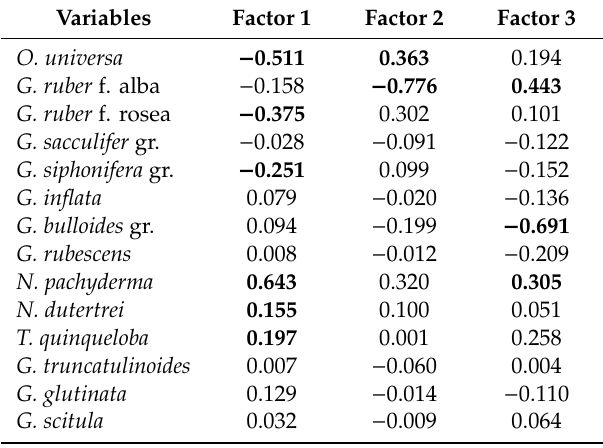
Table 4. Ranking of the planktonic foraminiferal species and their factor loadings along the PCA factors in core KIM-2A. Bold data indicate the most important factor loadings in each